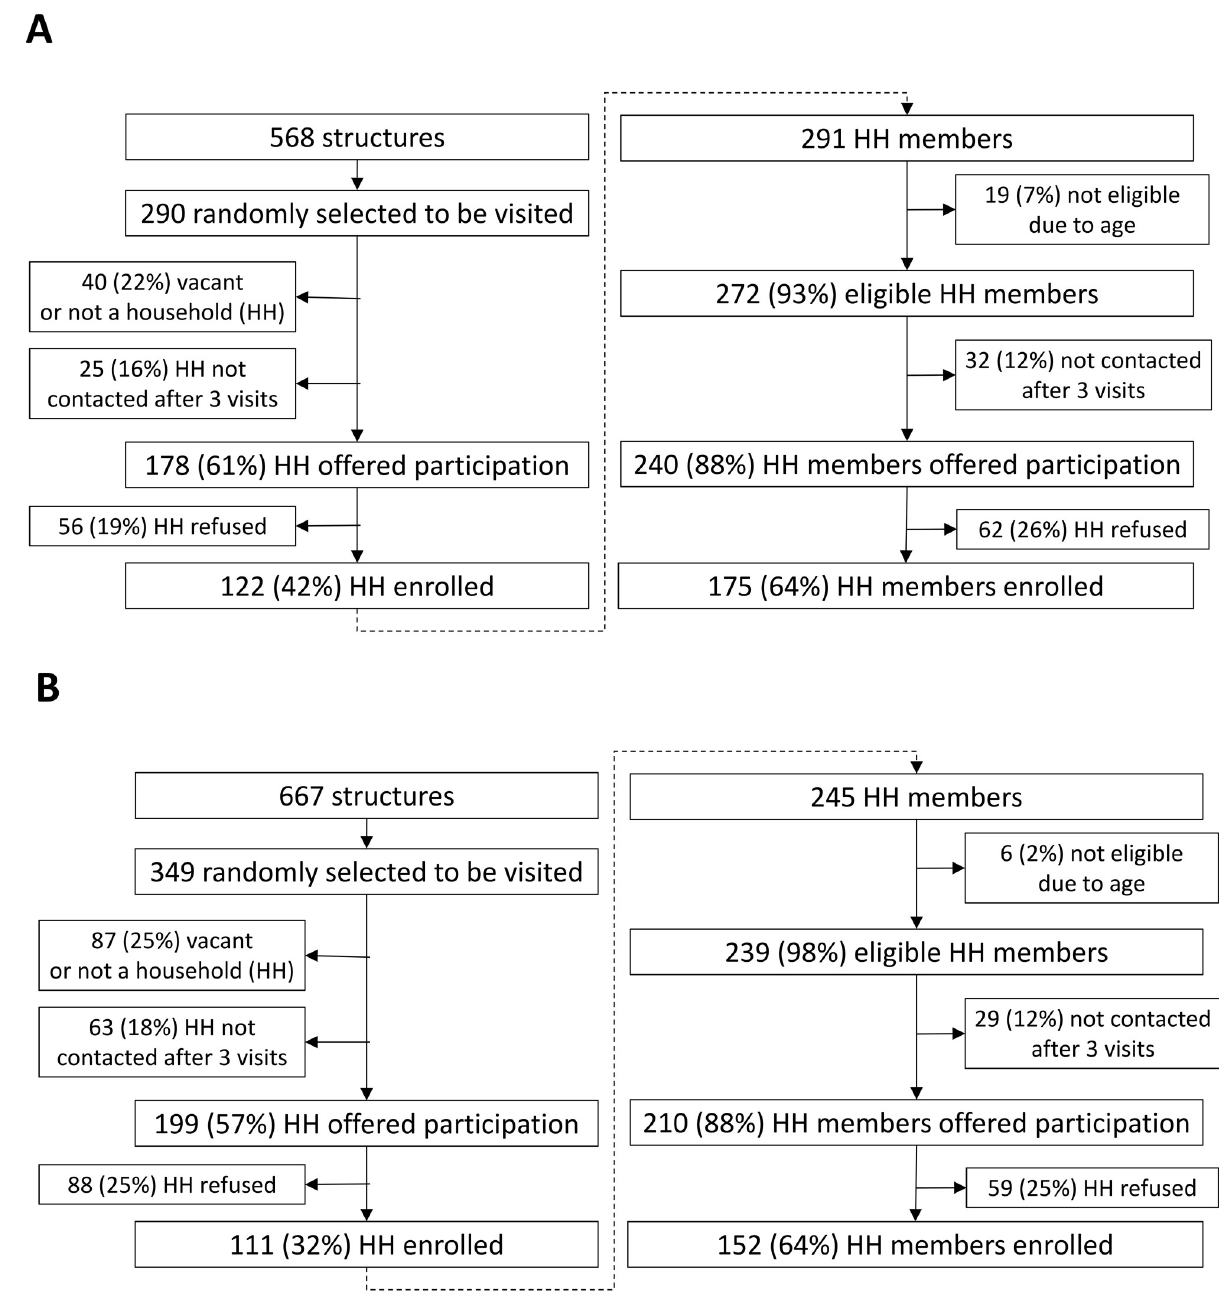
Fig 1. Enrollment of households and household residents in a survey of chikungunya virus seroprevalence among communities with (A) or without (B) autocidal gravid ovitraps (AGO traps) in Puerto Rico, November 2015–February 2016.